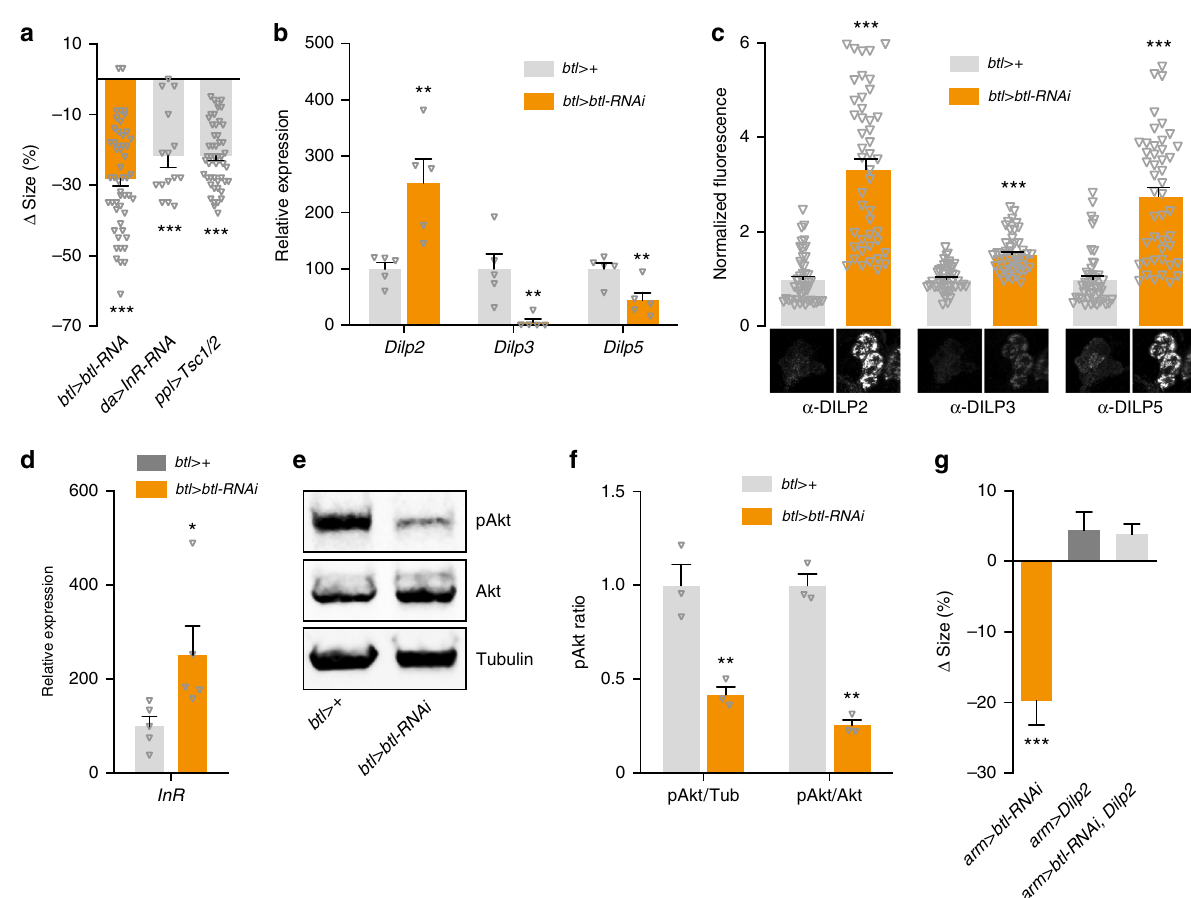
Fig. 3 Breathless modulates systemic growth by altering DILP signaling. a Trachea-speci fi c knockdown of breathless ( btl ) mimics loss of insulin signaling induced by ubiquitous InR knockdown ( da > InR-RNAi ) and fat-body inhibition of Tor ( ppl > Tsc1/2 ), which remotely inhibits release of insulin-like peptides (DILPs) from the insulin-producing cells (IPCs). Values are percent change in pupal size vs. the btl > + controls ( btl > crossed to w 1118 ). n = 15 – 79. b , c Levels of whole-animal Dilp transcripts and DILP peptides in the IPCs in btl > btl-RNAi animals with knockdown of btl in the trachea compared with btl > + controls. Representative images of DILP2, -3, and -5 immunostainings are shown below. b : n = 5. c : n = 44 – 45. d Increased expression of InR in btl > btl- RNAi animals compared with btl > + controls suggests reduced systemic insulin signaling. n = 5. e , f Immunoblotting showing whole-animal levels of phosphorylated Akt (pAkt) ( e ) in btl > btl-RNAi animals compared with btl > + controls, quanti fi ed in f from three independent replicates normalized to Tubulin (Tub) or Akt levels. f : n = 3. g Ectopic expression of Dilp2 rescues the btl- knockdown size phenotype. Ubiquitous weak knockdown of btl using armadillo-GAL4 ( arm > btl-RNAi ) leads to small pupae (left). Co-expressing Dilp2 rescues this size phenotype (right), while having no signi fi cant effect on control animals (middle). Values are percent change in pupal size versus arm > + controls. n = 14 – 113. Statistics: one-way ANOVA with Dunnett ’ s test